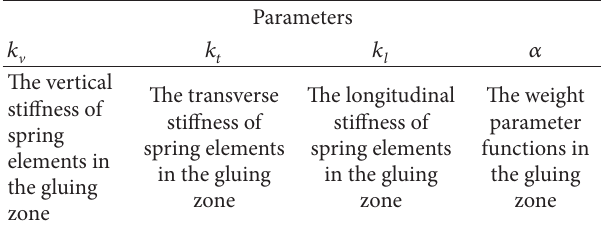
Table 1: Parameters